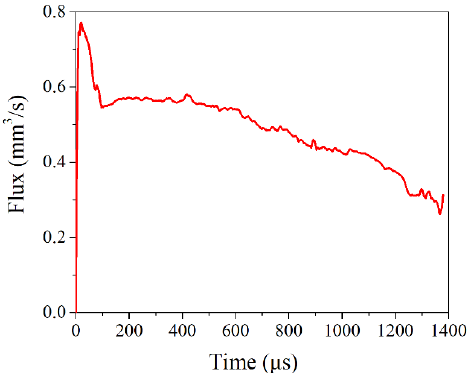
Figure 8. Inlet flow variation curve of sealing surface.